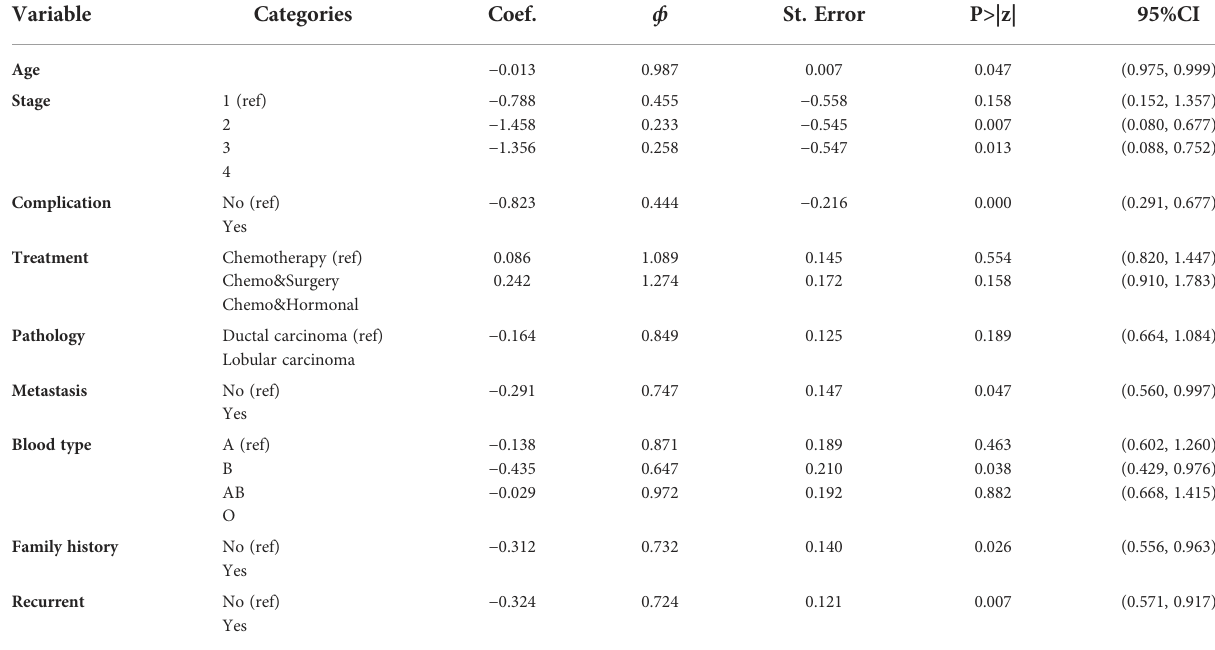
TABLE 6 Summary result for Weibull accelerated failure time